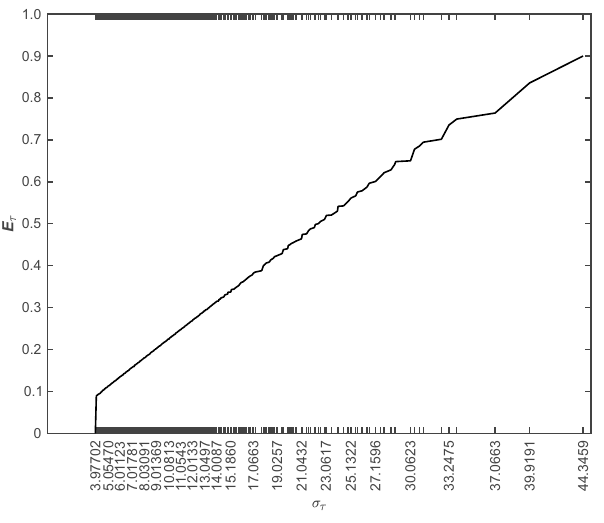
Fig. 5 Relative error EOFs.